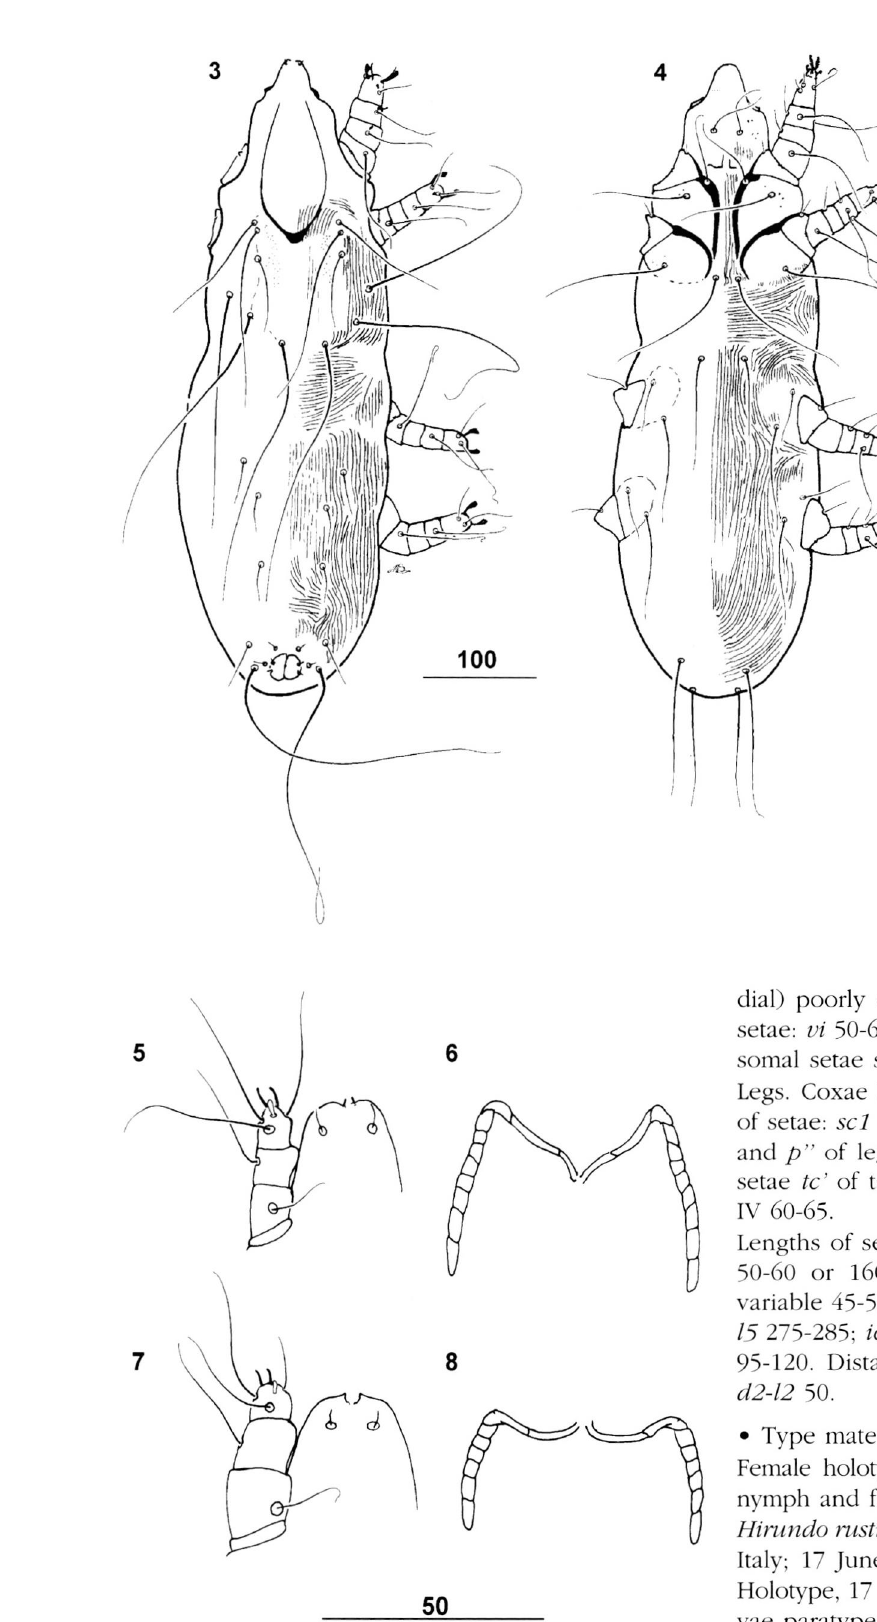
Figs 5, 6. - Syringophiioidus hirundinis sp. n. Female. 5. Hypostomal apex ventral view. 6. Peritremes. Figs 7, 8. — Syringophiioidus hirundinis sp. n. Male. 7. Hypostomal apex ventral view. 8.